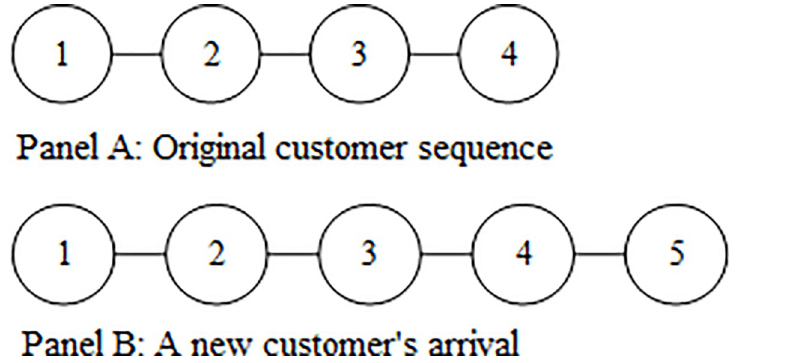
Fig 2. Two customer sequences.